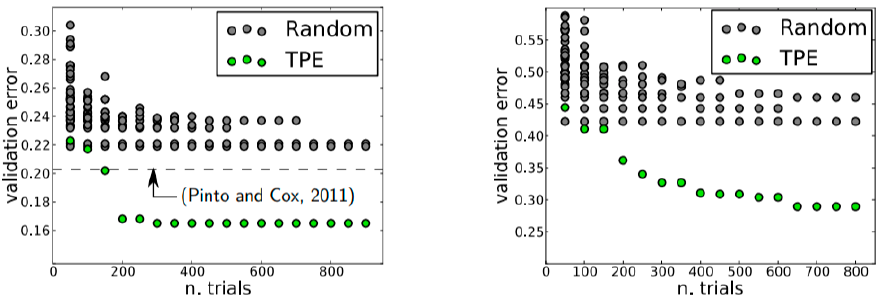
Figure 1. Comparison of the TPE-optimization and random search validation set performance on the different datasets [15].